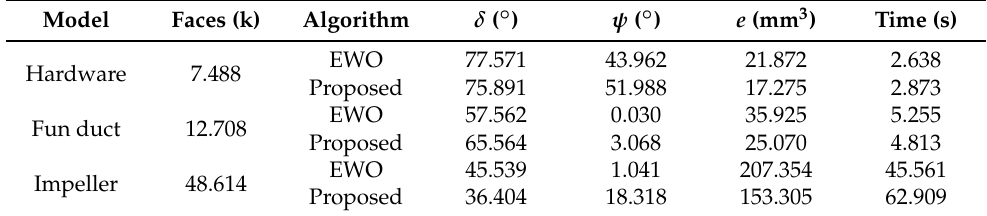
Table 2. Volume error comparison in different methods via more